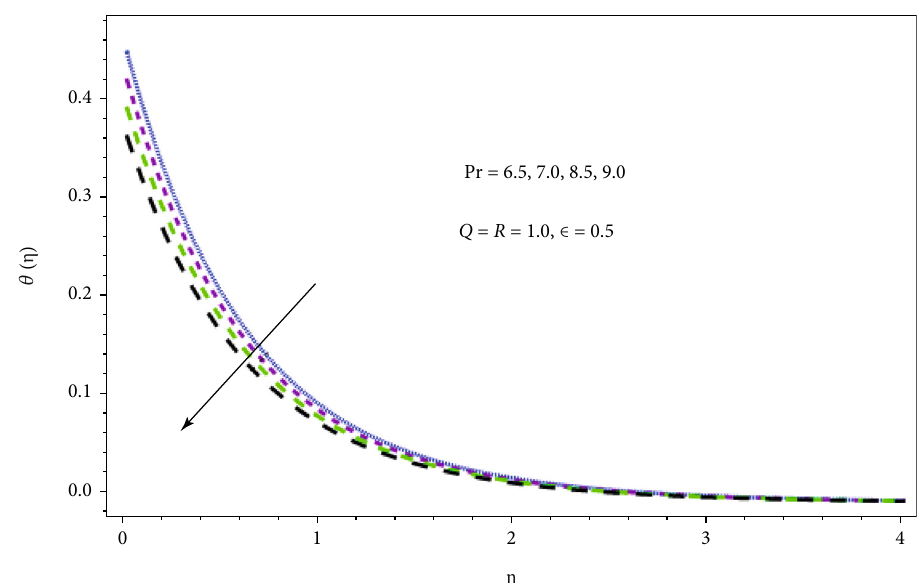
Figure 8: Graphical view to show the e ff ect of Pr on θ ð η Þ .